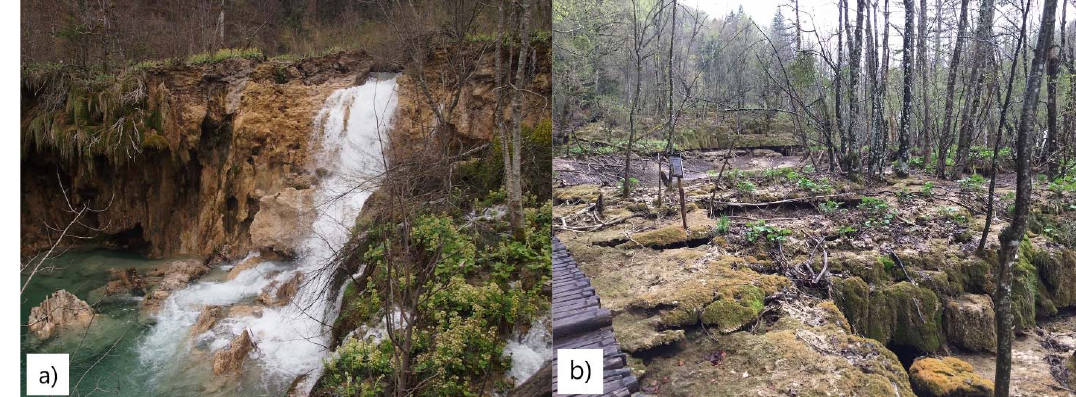
Figure 14. Milino Lake on 9 April 2018 (photo: Plitvice Lakes National Park staff): ( a ) broken ‐ off piece of the tufa barrier, ( b ) dried ‐ out part of the channel.